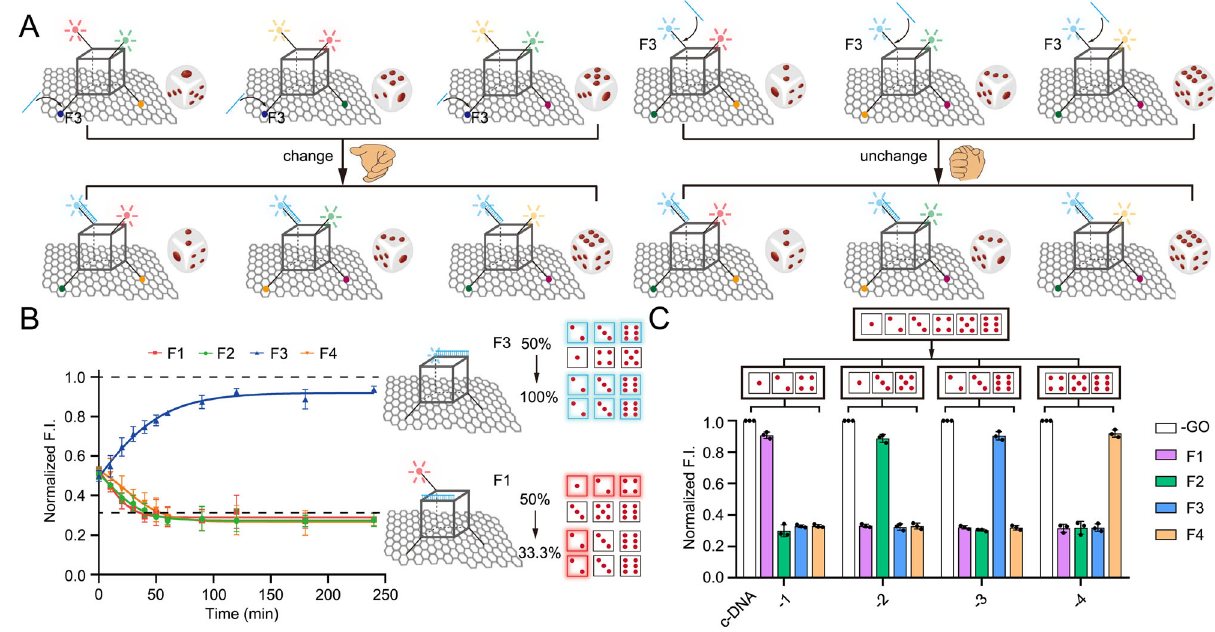
fl uorescence of dice. C Normalized fl uorescence intensity of four signals after adding four kinds of c-DNA, separately, n =3 independent experiments. Data are presented as mean values±s.d. Source data are provided as a Source Data fi